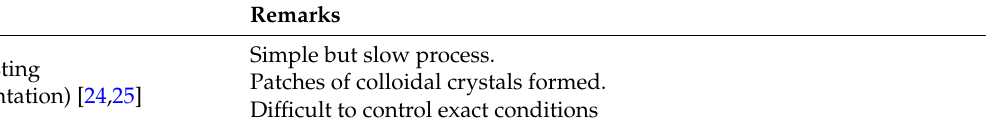
Table 1. List of methods commonly used for colloidal